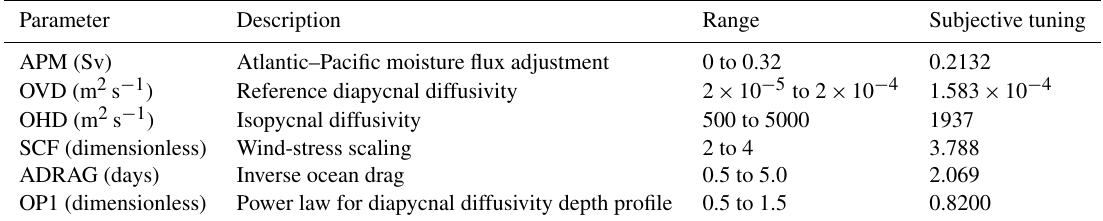
Table 1. Ensemble varied